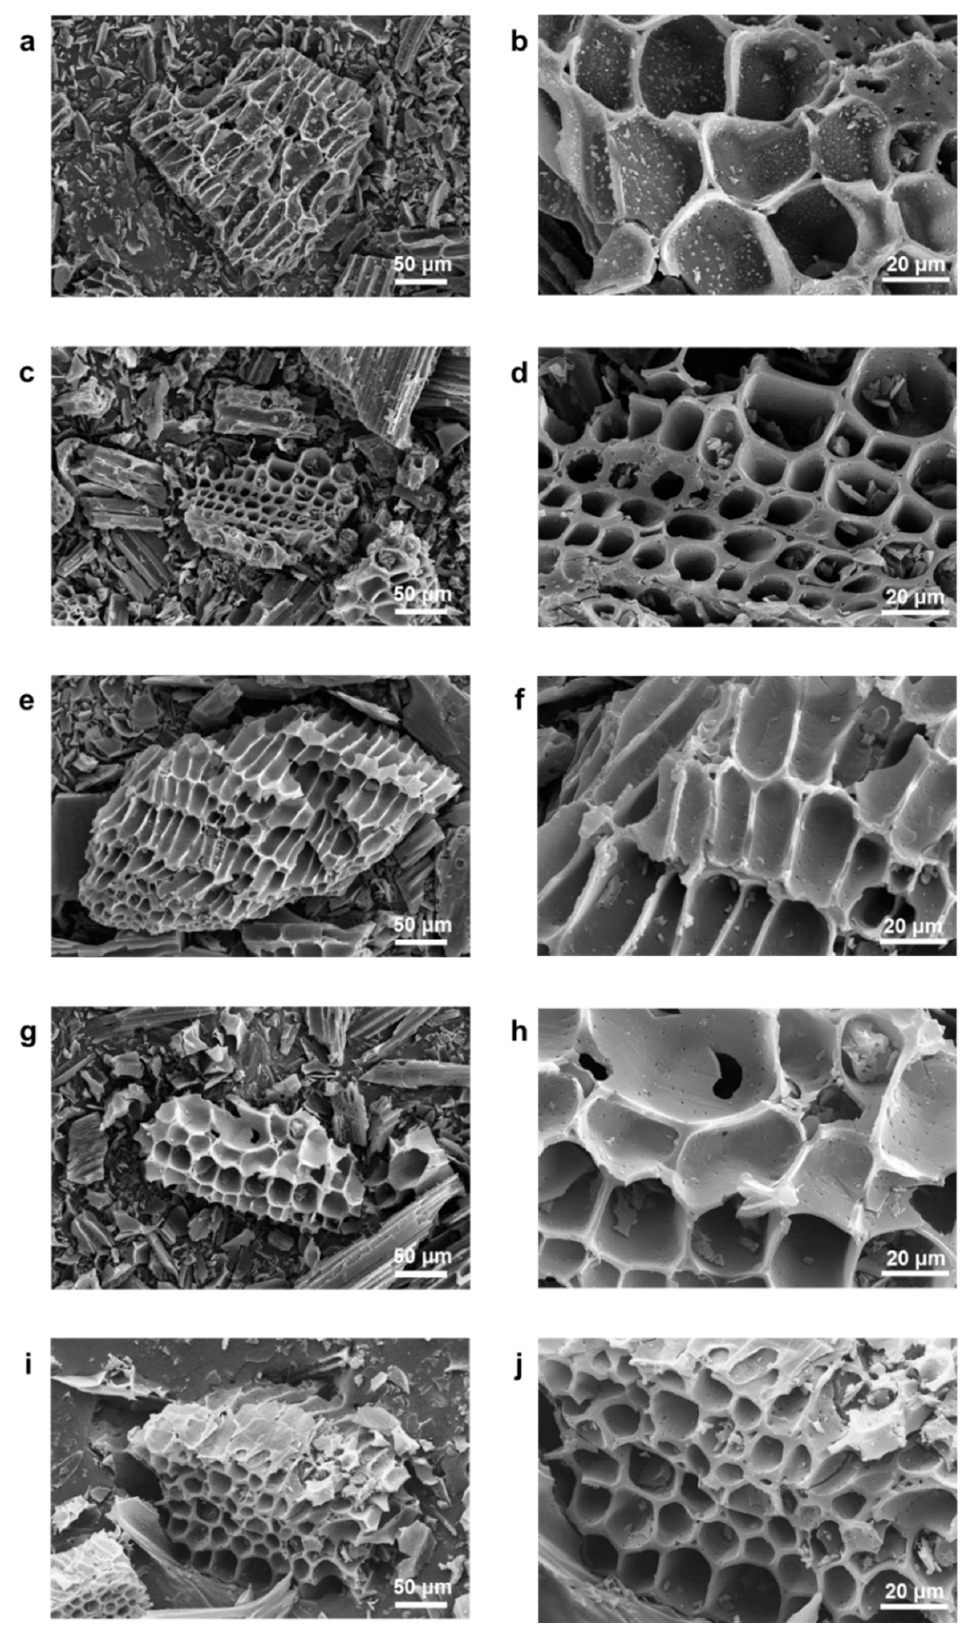
Figure 1. FE-SEM images of ( a , b ) WB, ( c , d ) NE2-C-AEMs, ( e , f ) NE4-C-AEMs, ( g , h ) NE6-C-AEMs, and ( i , j ) NE8-C-AEMs characterized in different magnifications.